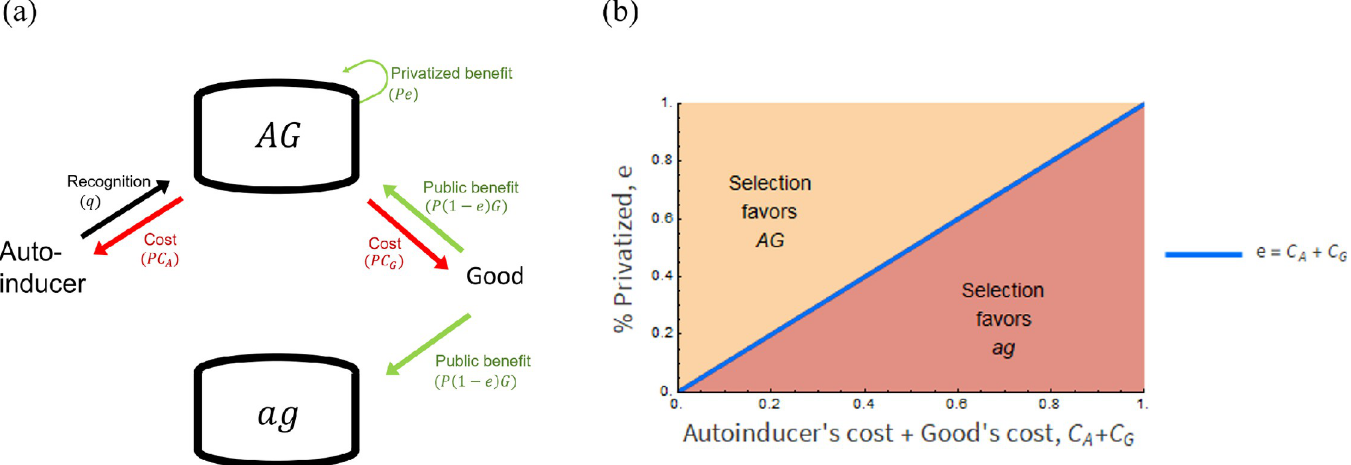
Fig 1. The partially privatized benefit enables AG to outcompete ag . (a) A schematic of the social interaction between strains AG and ag . Red arrows indicate a costly production of a good and an autoinducer. The black arrow indicates that the autoinducer triggers the production of functional alleles ( A and G ). Green arrows indicate the access to the good’s benefits. AG accesses both public and private benefits, while ag accesses only public benefit. (b) A geometric visualization of which strain selection favors. In yellow and red areas, selection favors pure populations of AG and ag , respectively. The blue line is where both strains are equally fit, which happens when the per capita partially privatized benefit equalizes to the sum of the per capita costs of producing an autoinducer and a good. This result is valid for parameters: 0 � L � 1 and etc.) and the equations used for the analysis, having either q 6¼ 0, or q 0 6¼ 0 or 0 < q 0 , q � 0.5. Please see Table 2 and Section 6A for the definition of letters ( q , C A respectively. All mathematical analyses assumed an unstructured